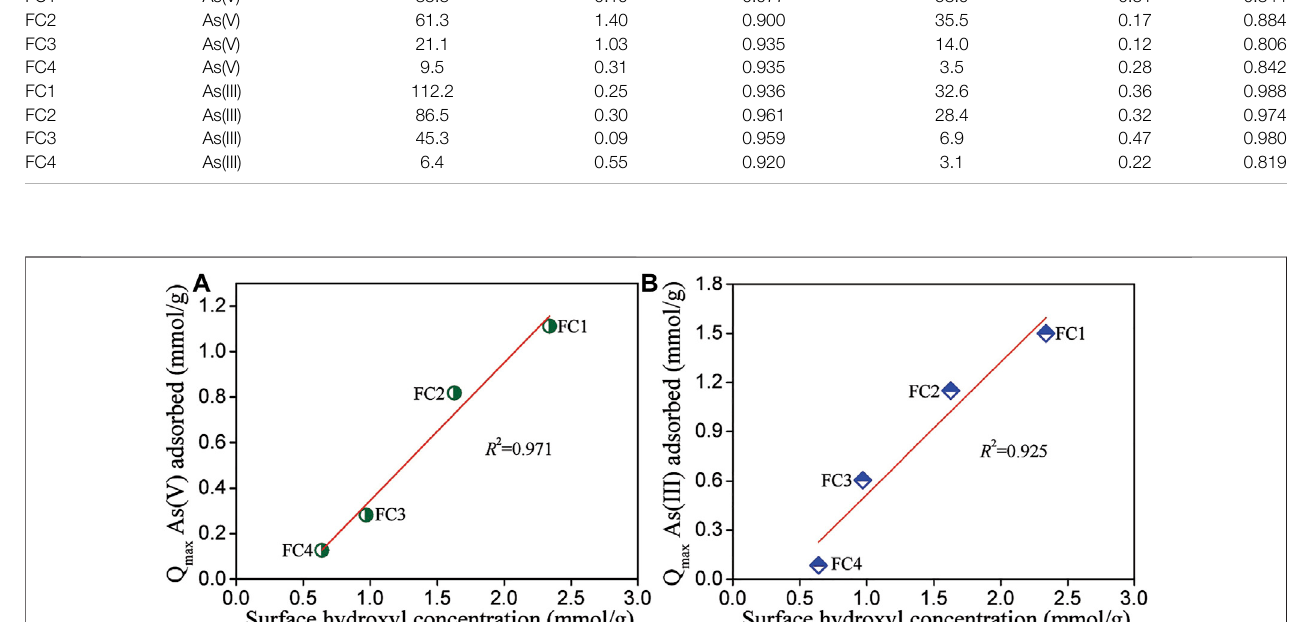
FIGURE 6 | Relationship between surface hydroxyl concentration and (A) As (V) and (B) As (III) adsorption capacities of Fe-Cu binary oxides.